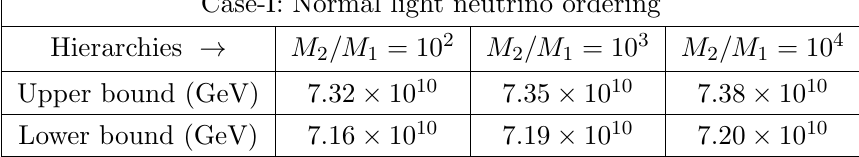
Table 4 . Lower and upper bounds on M 1 for di(cid:11)erent mass ratios of the RH neutrinos.